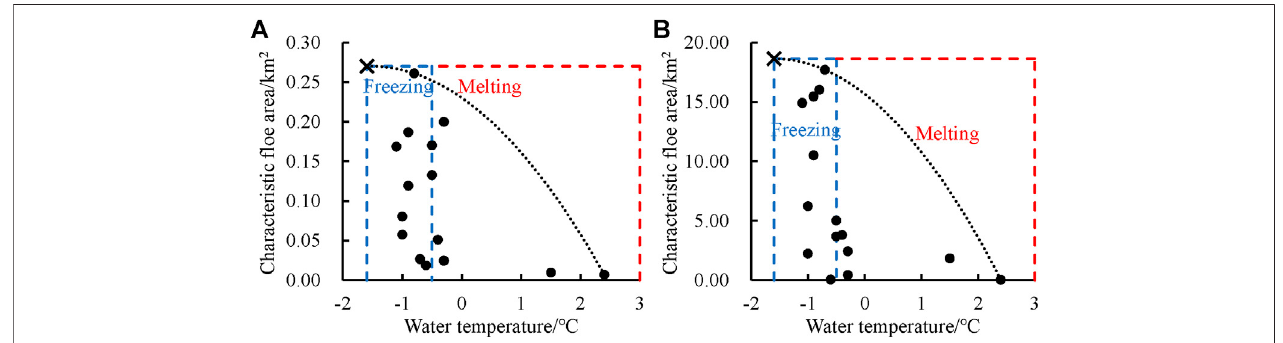
FIGURE 10 | Characteristic fl oe area versus water temperatures at site 26 of the Laizhou Bay. The characteristic fl oe area corresponds to (A) 90% and (B) 100% cumulative probabilities. The black dotted line is the upper envelope curve of data points. The blue and red frame areas represent drift ice ’ s freezing and melting cases. The value of the black cross is the design fl oe